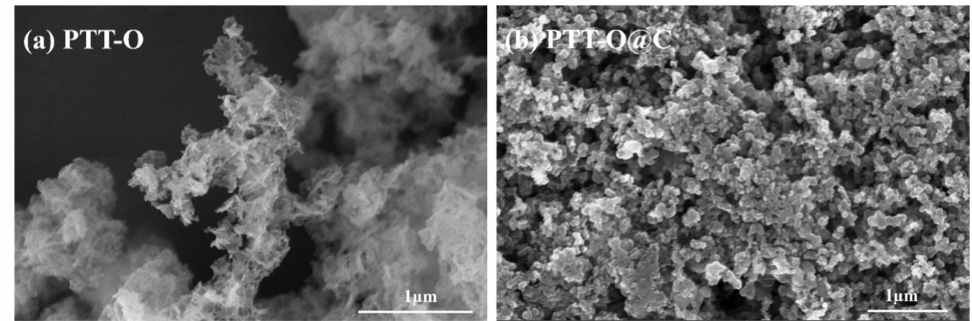
Figure 2. The SEM images of ( a ) PTT-O and ( b ) PTT-O@C.